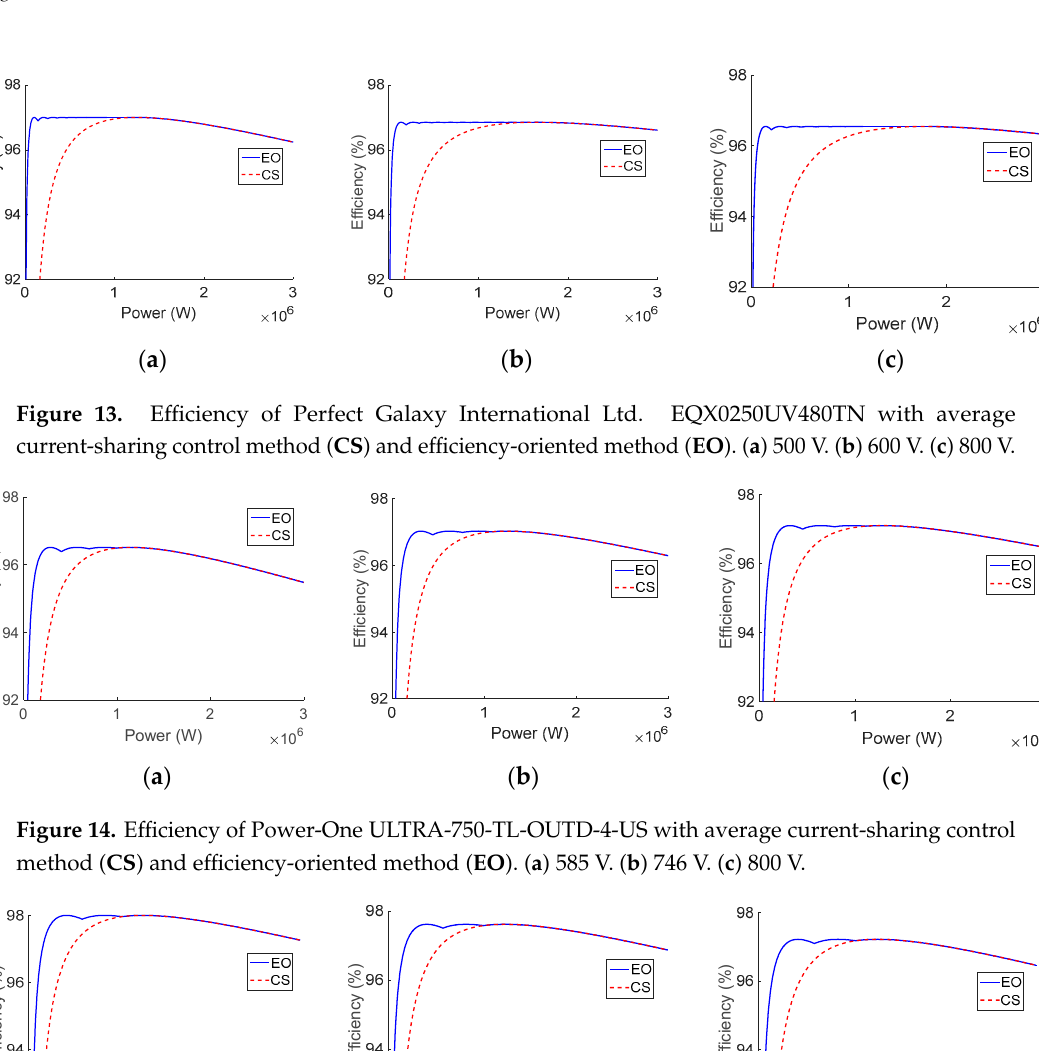
Figure 12. Efficiency surfaces with average current-sharing control method ( CS ) and efficiency- oriented method ( EO ). ( a ) Perfect Galaxy International Ltd EQX0250UV480TN. ( b ) Power-One